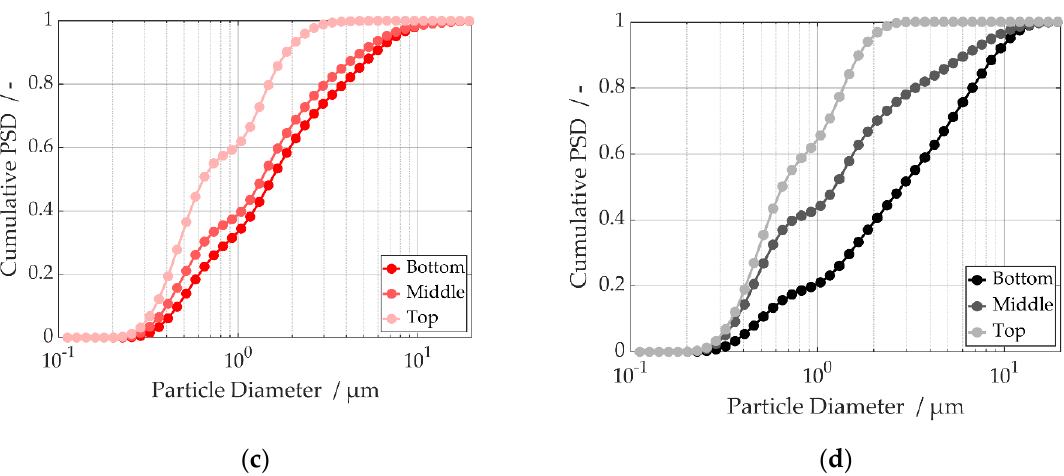
Figure 9. Sediment particle size distributions for the three cases and at bottom, middle and top axial position. Blue: 20,000 rpm; Red: 40,000 rpm; Black: Increasing rotational speed. ( a ) Characteristic particle sizes, squares: x 10 ; triangles: x 50 with dashed lines as guides to the eye; stars: x 90 . ( b – d ) Detailed particle size distributions for the three cases at axial positions bottom (darkest), middle (moderate shade), top (lightest).